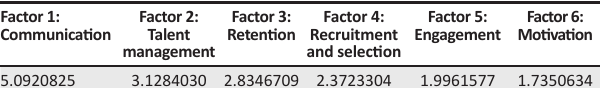
TABLE 3: Total variance explained by each factor.